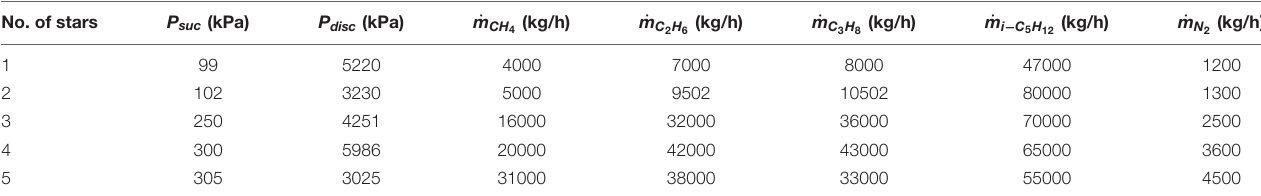
TABLE 3 | A sample of initial population of stars. No. of stars